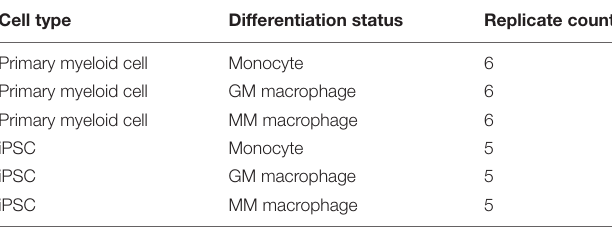
TABLE 1 | Overview of the RNA samples for NGS